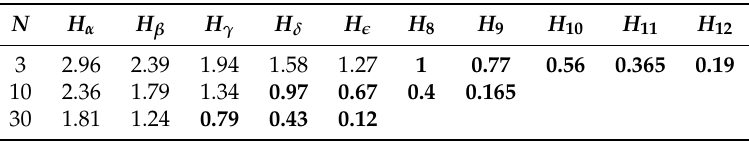
Table 2. Relative importance of penetration for all lines in the series and plasma parameters considered ) is displayed as a function of the electron density N for all series in the workshop examples. ln ( ρ max ρ min lines considered in the bound-bound spectrum calculation. The density N is expressed in units of 10 17 e/cm 3 . Bold is used for cases where the strong collision term is comparable to or dominates the weak collision contribution. N H